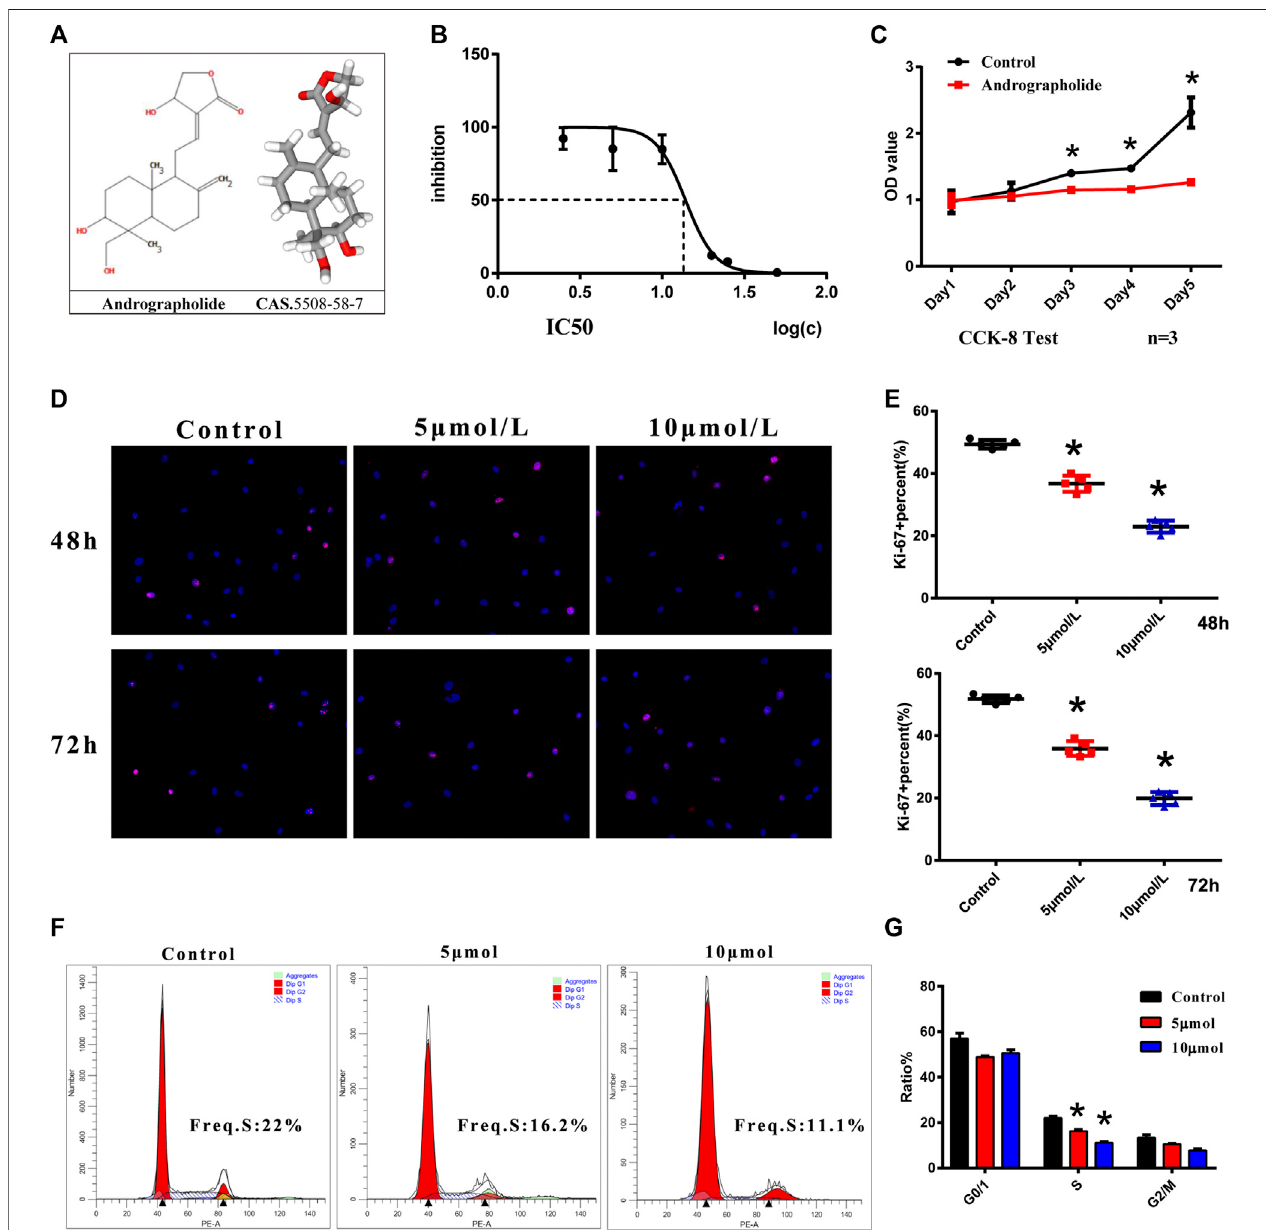
FIGURE2| CellviabilityandproliferationofVICswithAGPtreatment. (A) Two-andthree-dimensionalmolecularstructureofAGP. (B) CytotoxicityofAGPonVICs. (C) CellproliferationcurveafterAGPtreatment(10 μ M)for5 dayscomparedtothecontrols( n =3). (D) Ki-67stainingofVICswithAGPtreatment(red). (E) Percentageof Ki-67positivecells.(*) p < 0.05(vscontrol)indicatesasigni fi cantdifference. (F) FlowcytometryofcellcycleanalysisofVICsafterAGPtreatment(10 μ mol/L)for72 h. (G) S, G0/G1, and G2/M phase cells were counted and compared. (*) p < 0.05 (vs control) indicates a signi fi cant difference ( n =